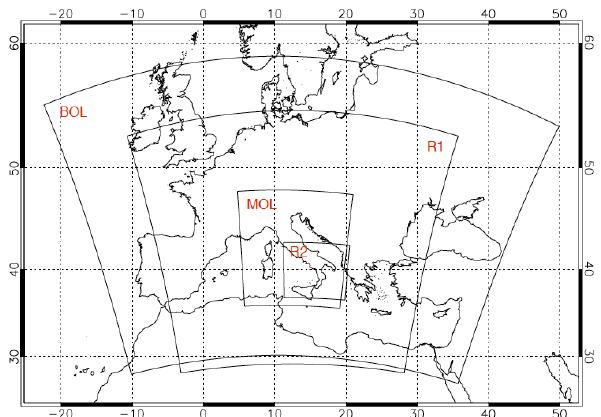
Figure 1. Model domains: BOL shows the BOLAM domain, MOL shows the MOLOCH domain, R1 shows the RAMS first domain, and R2 shows the RAMS second domain. The R2 grid is nested into the R1 grid with a two-way nesting.